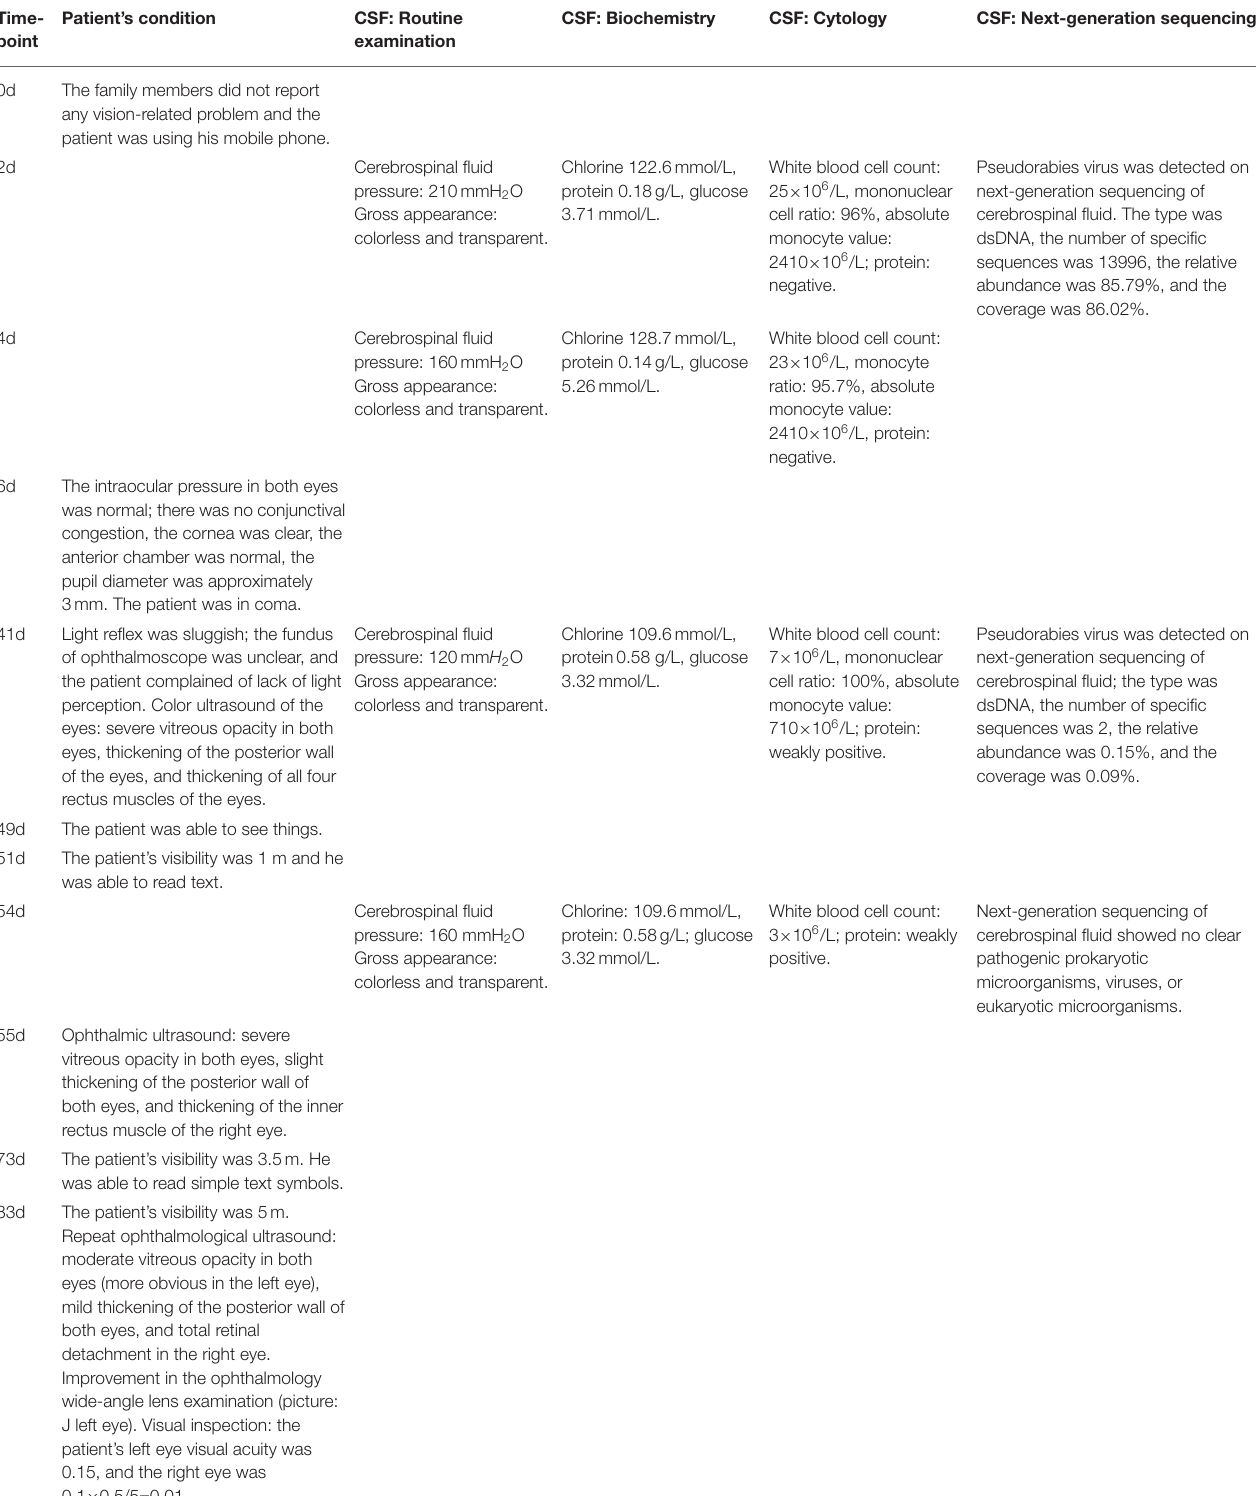
TABLE 1 | Temporal changes in the findings of cerebrospinal fluid examination and evolution of the patients’ ocular involvement during treatment and follow-up. Time- Patient’s point